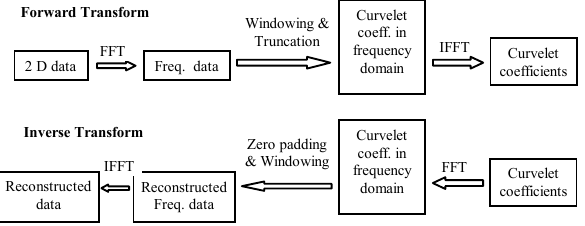
Fig. 4: Construction of Fast Discrete Curvelet